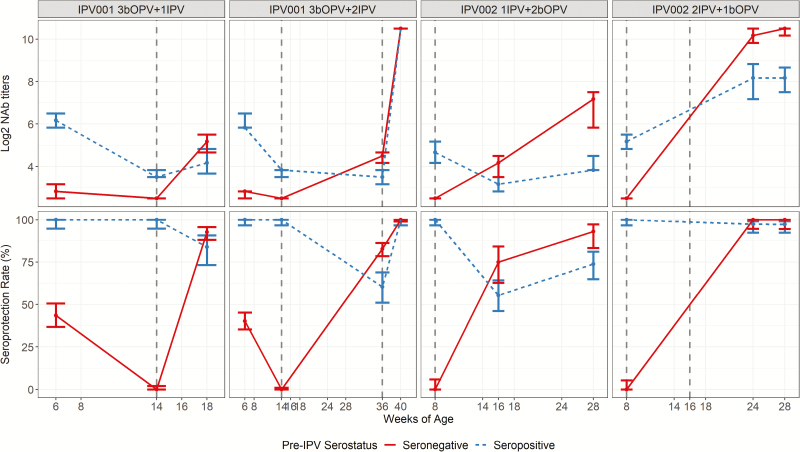
Poliovirus type 2 neutralizing antibody (NAb) titers (mean log2 values) and seroprotection rates (both given as estimates ± 95% confidence intervals [CIs]) according to serostatus before receipt of inactivated polio vaccine (IPV) and vaccination schedule among Latin American infants. Dashed vertical lines represent time points of IPV administration. Subjects in the IPV001 study were vaccinated with bivalent oral poliovirus (bOPV) at age 6, 10, and 14 weeks and with IPV at 14 weeks (single -IPV group) or at 14 and 36 weeks (2-dose IPV group). Subjects in the IPV002 study were vaccinated with IPV at age 8 weeks and with bOPV at 16 and 24 weeks (single-IPV group) or with IPV at age 8 and 16 weeks and bOPV at 24 weeks (2-dose IPV group).